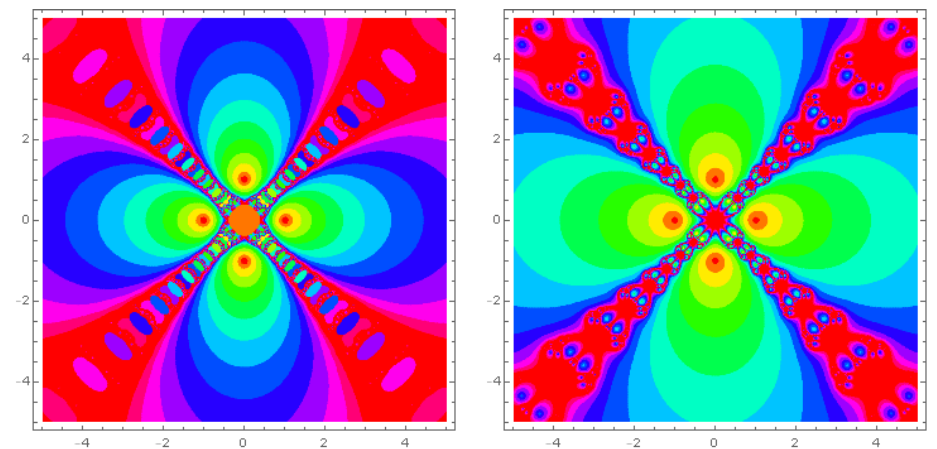
Figure 3. Attraction basins on f ( z ) = z 4 − 1 for the secant; Newton solvers on left and right, respectively.